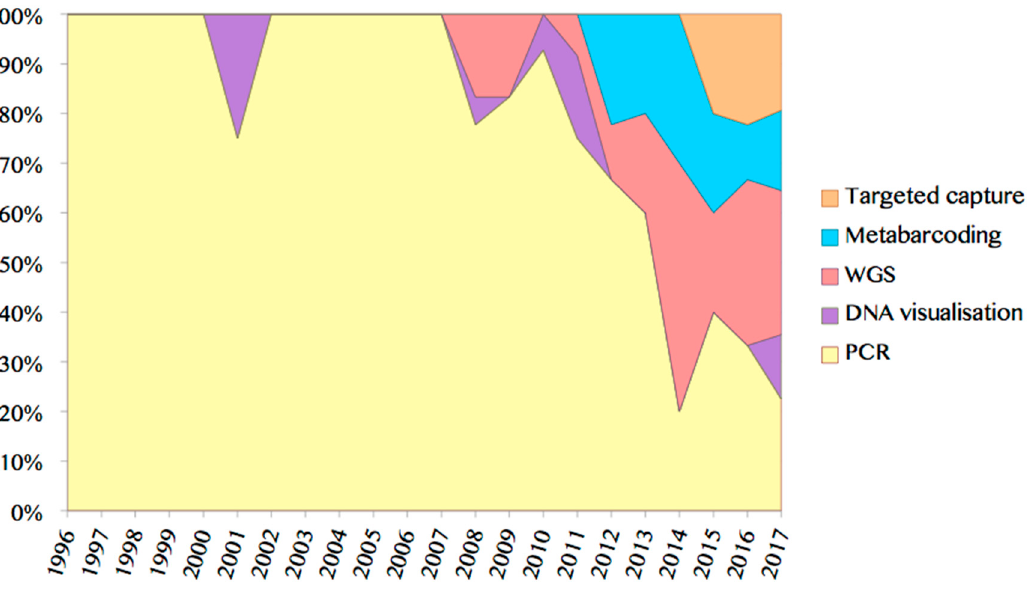
Figure 2. Area chart displaying the proportion of studies utilizing various methods in the analysis of neglected substrates, demonstrating the rise of whole genome and metagenomic approaches following the emergence of NGS technologies (includes studies reviewed in this paper, from 1996 to May 2017). WGS: whole genome sequencing; PCR: polymerase chain reaction.